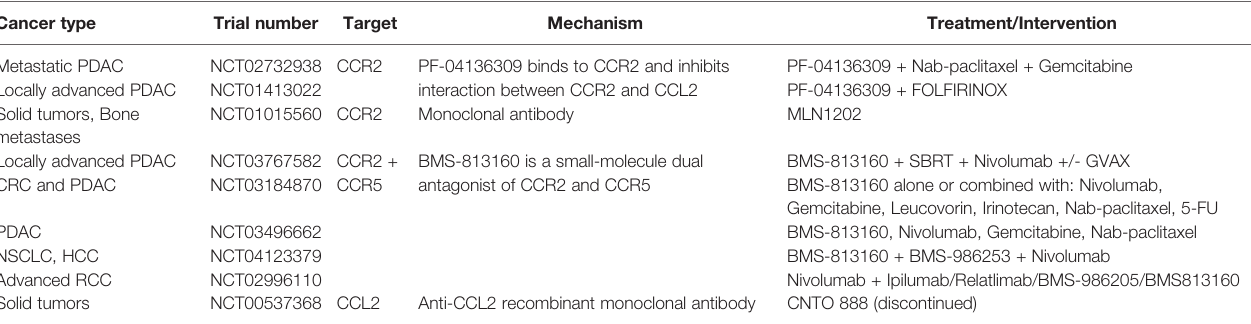
FOLFIRINOX, 5- fl uorouracil, leucovorin, irinotecan, and oxaliplatin; SBRT, stereotactic body radiotherapy; 5-FU, 5- fl uorouracil; GVAX, granulocyte-macrophage colony-stimulating factor (GM-CSF) gene-transfected tumor cell vaccine; PDAC, pancreatic ductal adenocarcinoma; CRC, colorectal cancer; HCC, hepatocellular carcinoma; RCC, renal cell carcinoma;